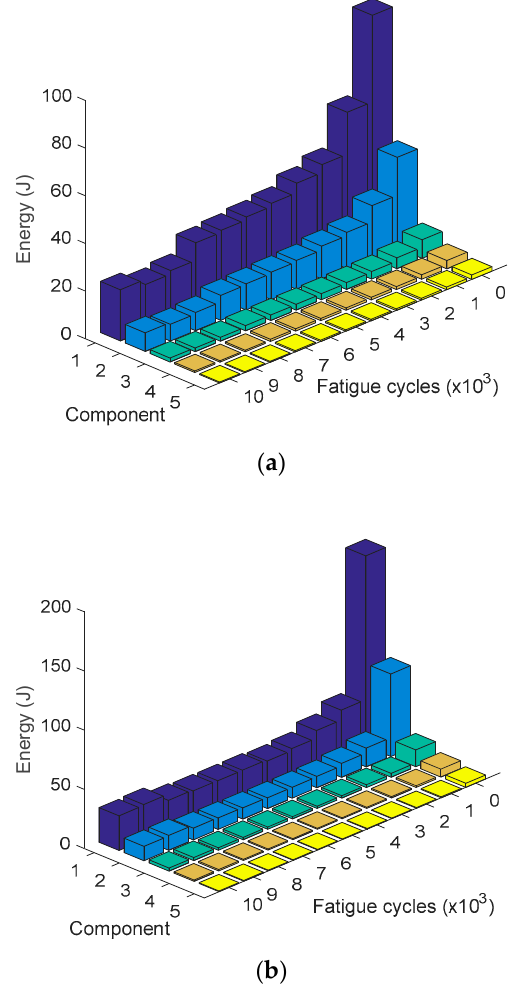
Figure 7. Variations of WP component energies of wave signals with fatigue cycles: ( a ) specimen S_A and ( b ) specimen S_B.